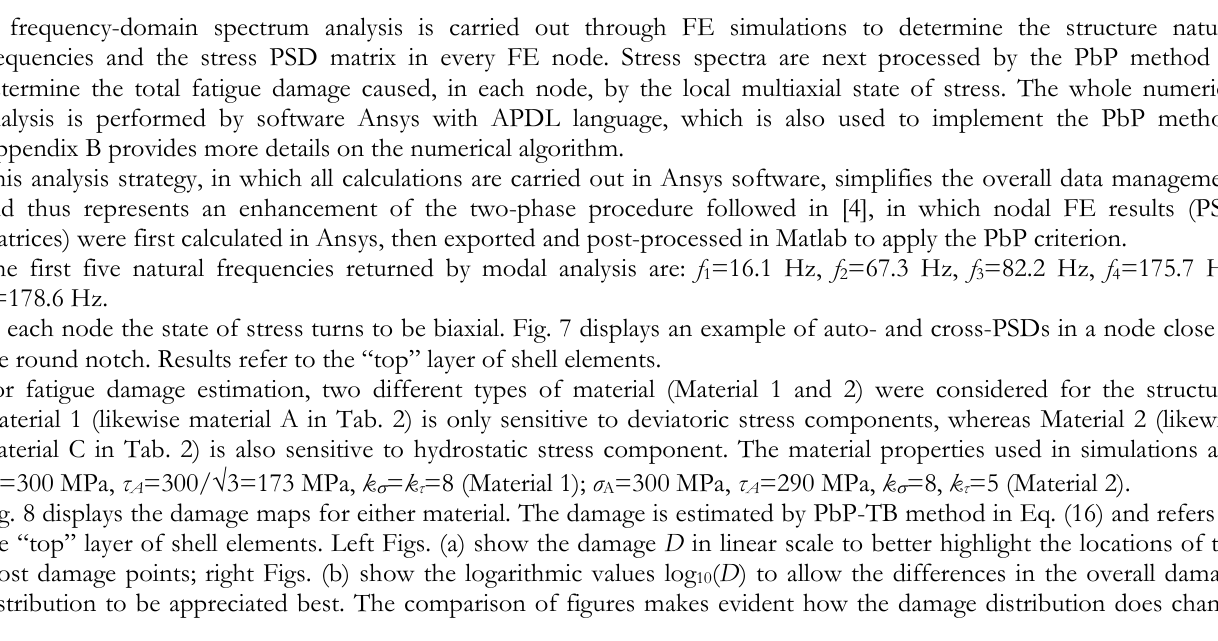
Figure 6: Geometry and finite element model of the L-shaped beam. Thickness is 0.5